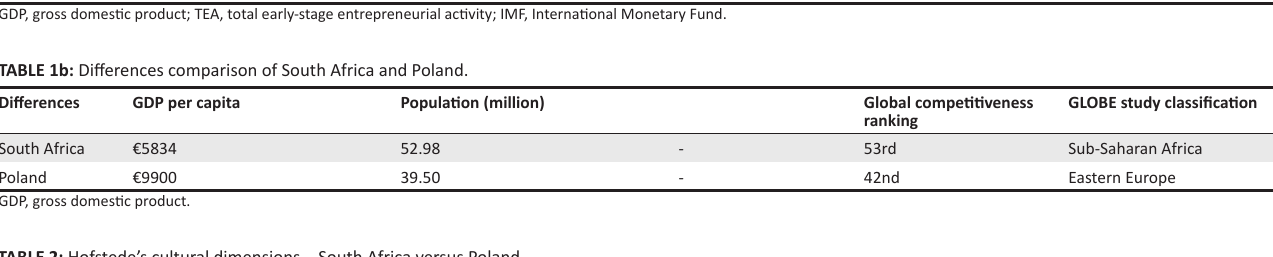
TABLE 2: Hofstede’s cultural dimensions – South Africa versus Poland. Hofstede’s cultural